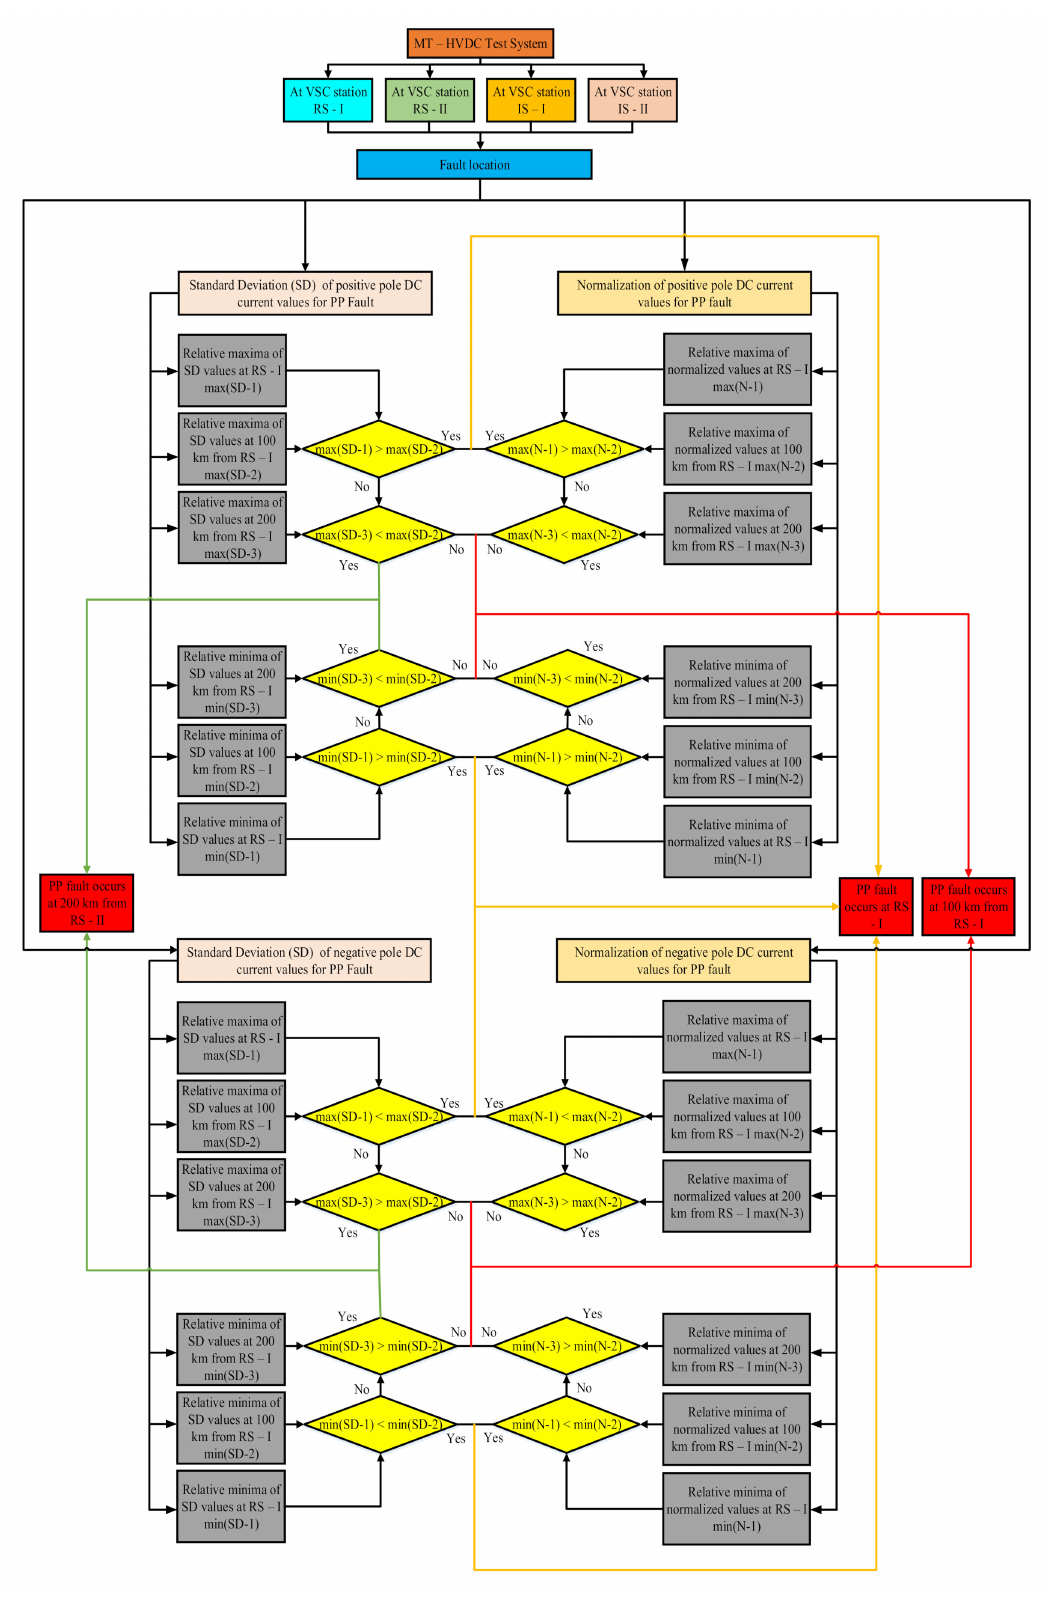
Figure 9. An algorithm for PP fault location finding based on SVM, using supported features of standard deviation and normalization of DC